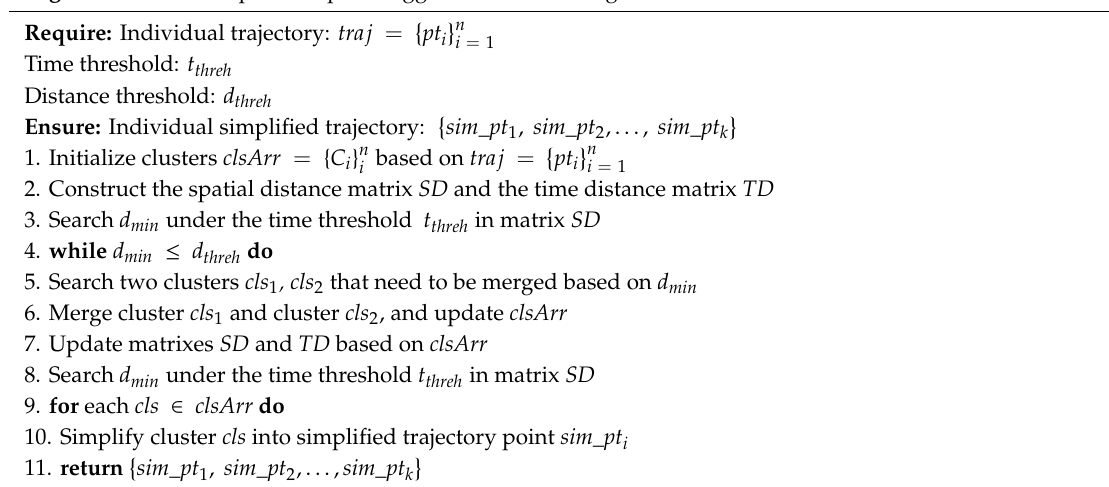
Algorithm 1 Indoor Spatiotemporal Agglomerative